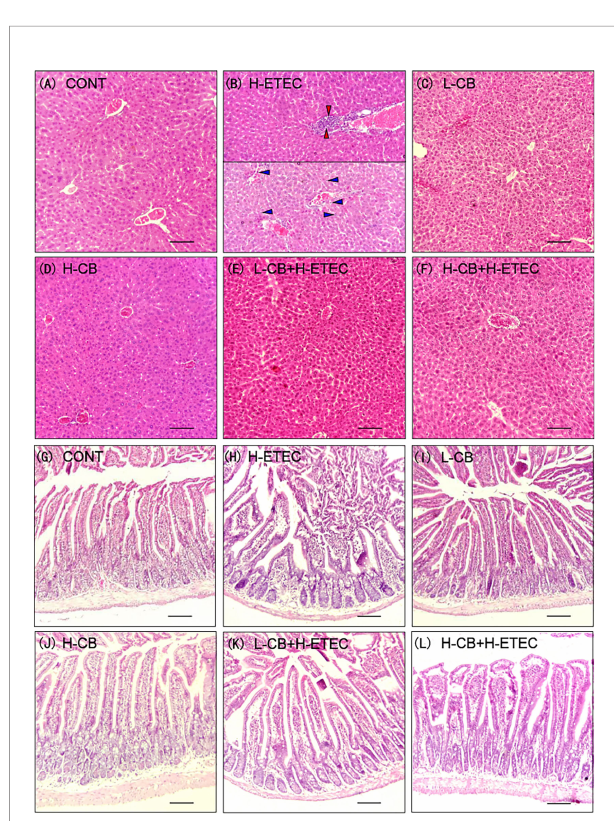
FIGURE 2 | Effects of CB and/or ETEC K88 on observation of tissular morphology. (A – F) hematoxylin-eosin staining in the liver of mice. (A) CONT, (B) H-ETEC, (C) L-CB, (D) H-CB, (E) L-CB+H-ETEC, (F) H-CB+H-ETEC; (G – L) hematoxylin-eosin staining in the jejunum of mice. (G) CONT, (H) H-ETEC, (I) L-CB, (J) H-CB, (K) L-CB+H-ETEC, (L) H-CB+H-ETEC. Bar = 100 m